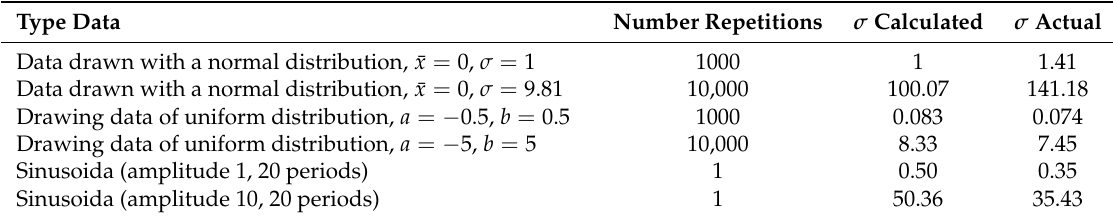
Table 1. Comparison of calculated and actual standard